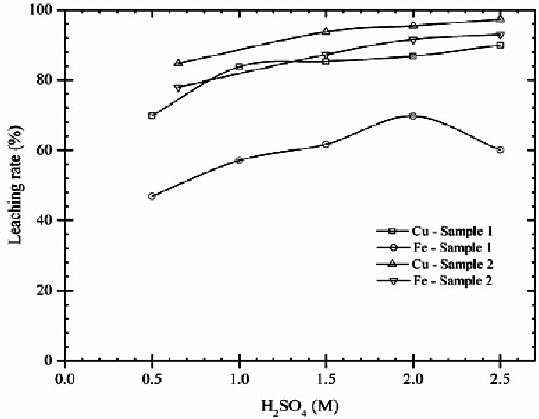
Fig. 4. Effect of H 2 SO 4 concentration on copper and iron